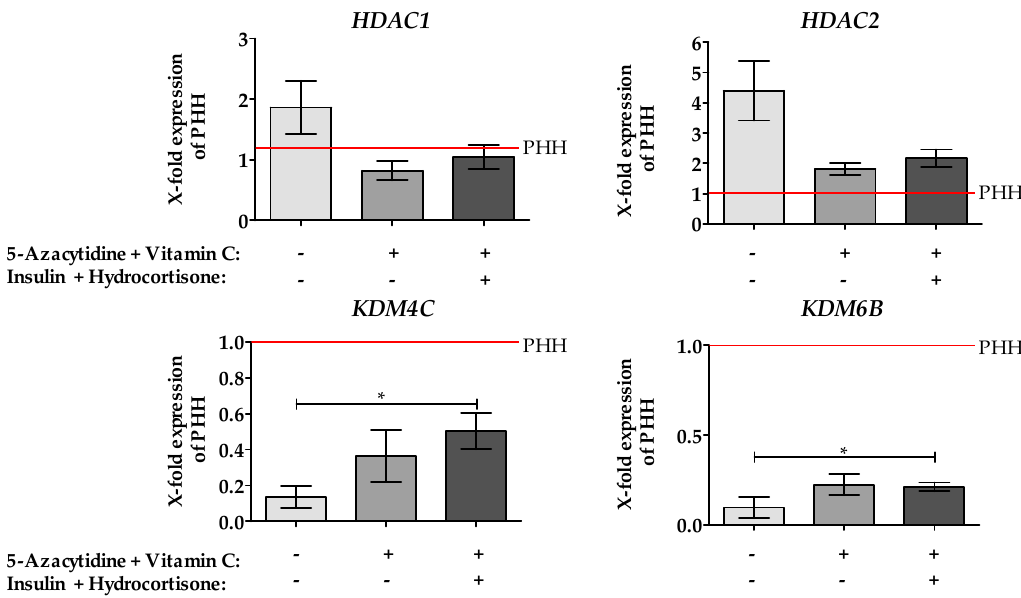
Figure 3. Effect of epigenetic modifying compounds on the expression of Chromatin Modifying enzymes. The expression levels of different chromatin modifying enzymes were measured by qRT-PCR. Unstimulated HepG2 cells (grey bars), as well as HepG2 cells after 48 h stimulation with 10 µM 5-AZA plus 0.5 mM Vitamin C with (dark bars)/ without (black bars) Insulin and hydrocortisone, were used. As a control, freshly isolated hepatocytes were used, (red line). Values were normalized to GAPDH and represent the mean of N = 3, n = 3. For the positive control a pooled sample of five different primary human hepatocyte (PHH) donors was used. Bars represent mean ± SEM * p ≤ 0.05 as indicated.